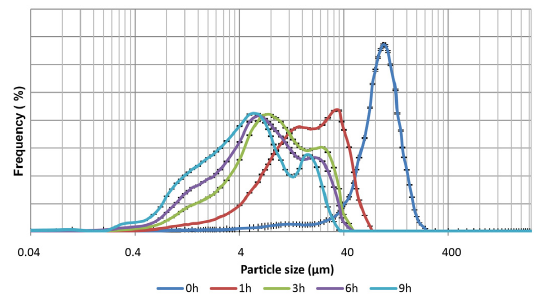
Figure 3. Histogram; frequency x milling